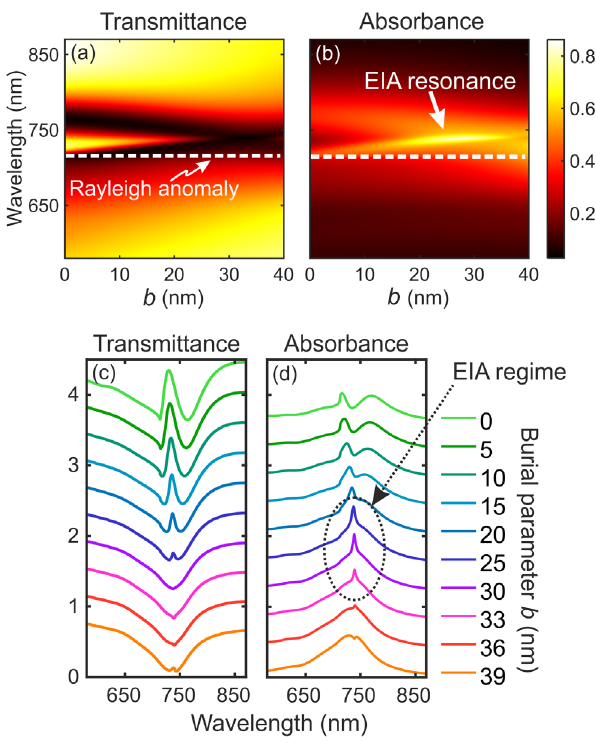
FIG. 2. (a),(b) Simulated transmittance and absorbance ( 1 − T − R , with T and R denoting transmittance and reflectance, respectively) for x -polarized incident light and different burial parameters b . For increasing b there is a gradual transition from the regime of induced transparency to induced absorption. The white dotted line indicates the Rayleigh anomaly. (c),(d) Slice cuts for a clearer view on the line shapes of the spectra. The oval indicates the EIA regime, characterized by very sharp induced absorption